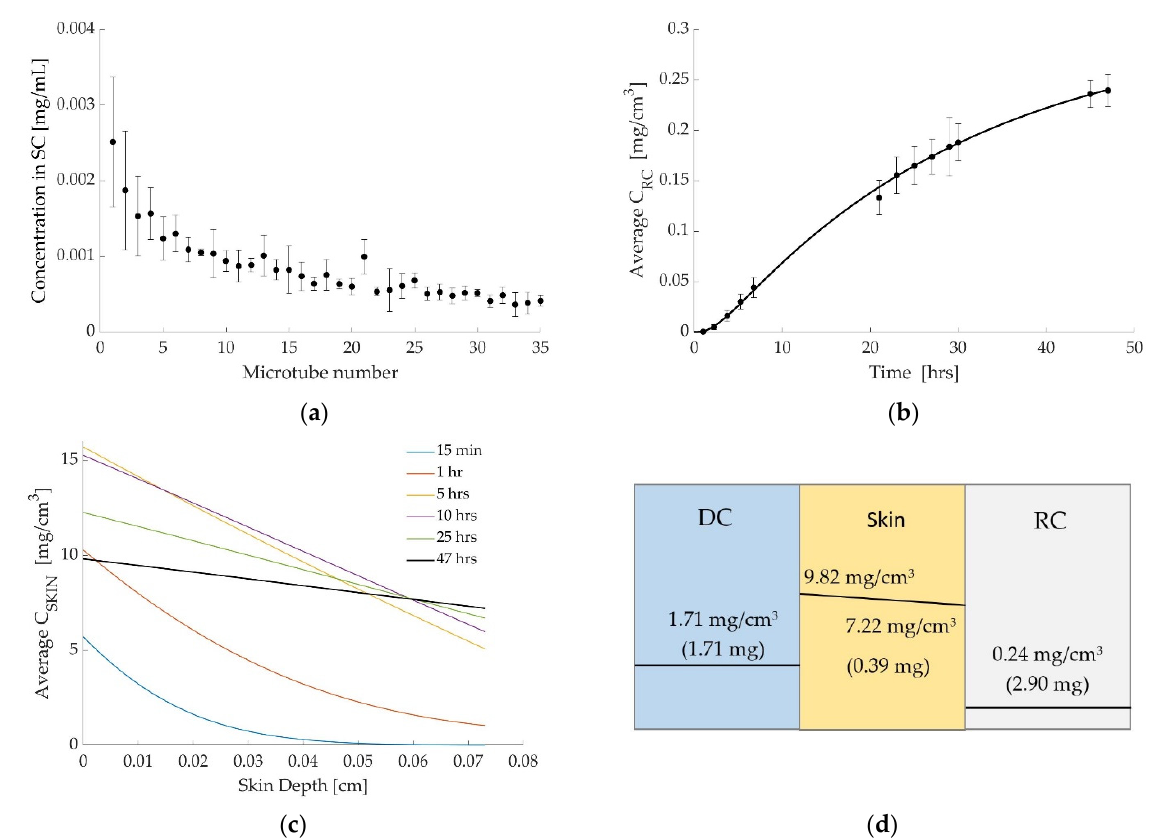
Figure 3. Diclofenac at room temperature. ( a ) Tape stripping results (mean of all replicates ± standard deviation ( n = 4)). Microtube no. 1 represents tapes no. 1–2 in the top layer of SC and no. 35 represents tapes no. 69–70. ( b ) Simulated release curve (solid line) and experimental results (marker). ( c ) Simulated concentration profiles in the skin at different times. ( d ) The concentration and the amount of drug in each layer at the end of the simulation, showing discontinuity between layers.